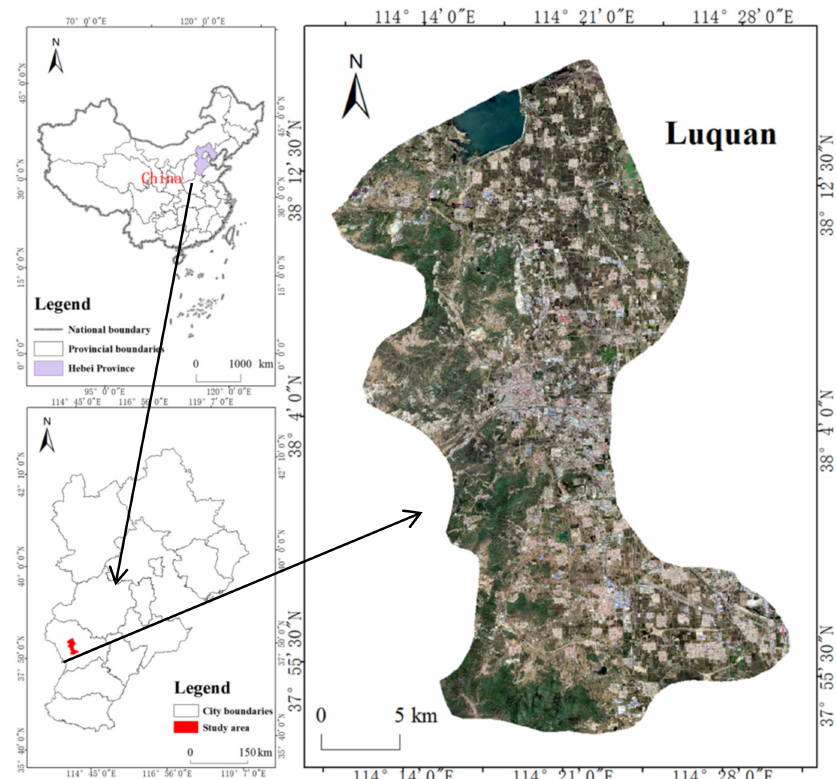
Figure 1. Location of the study